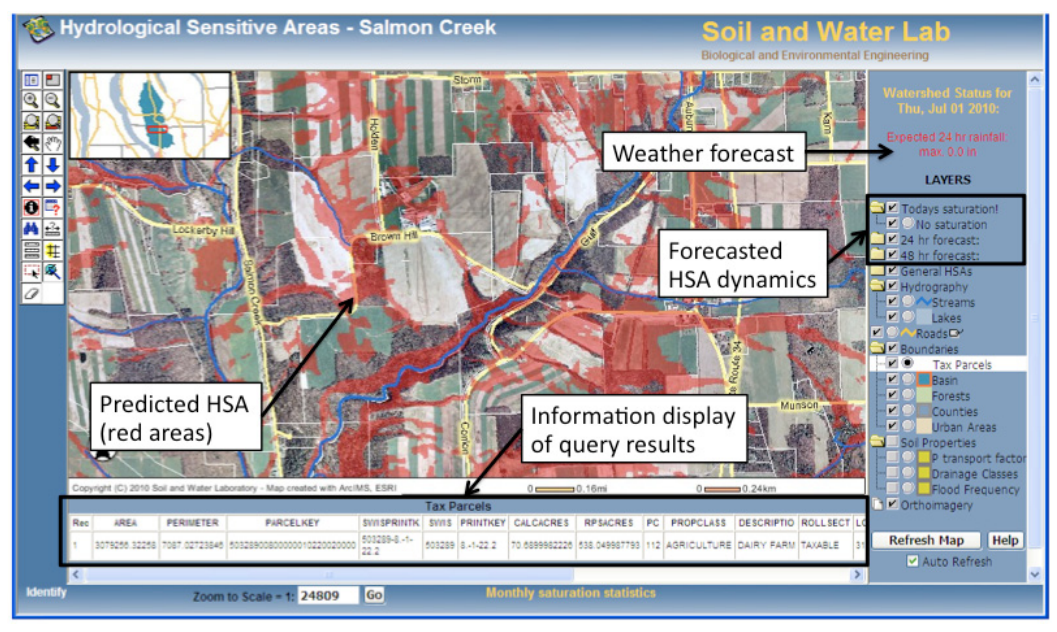
Figure 5. User interface of the HSA prediction tool. Red areas show HSA predicted with the semi-distributed water balance model. A daily update of forecasted weather conditions and HSA dynamics in Salmon Creek watershed is given in the top, right